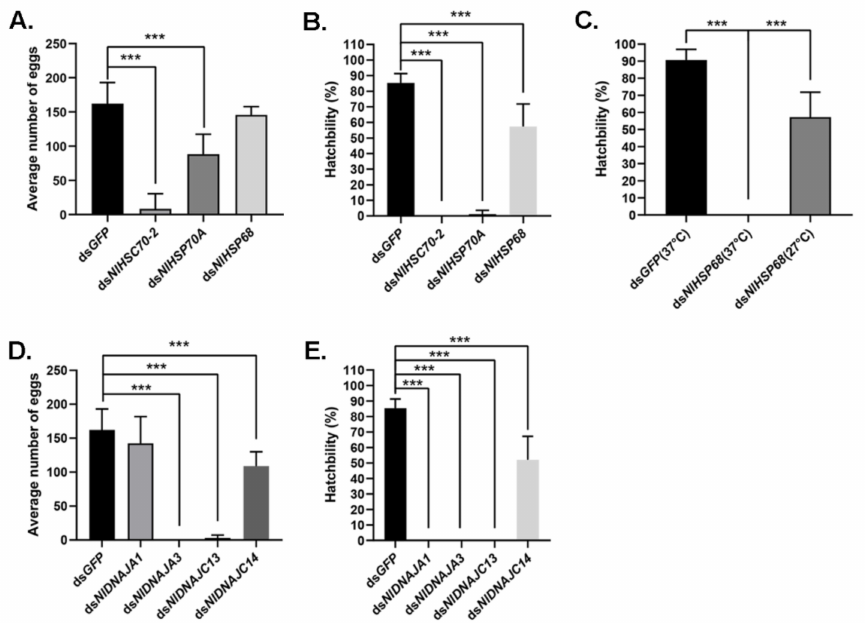
Figure 7. Effects of dsRNA treatments on female fecundity. ( A , D ) Average number of eggs laid by each female after different RNAi treatments. ( B , E ) Egg hatchability after RNAi treatment under normal conditions. ( C ) Egg hatchability of NlHSP68 after RNAi treatment under normal conditions and thermal stress. For each treatment, 10 replicates were set. Results are presented as mean ± SEM. *** p < 0.001 (Student t -test).